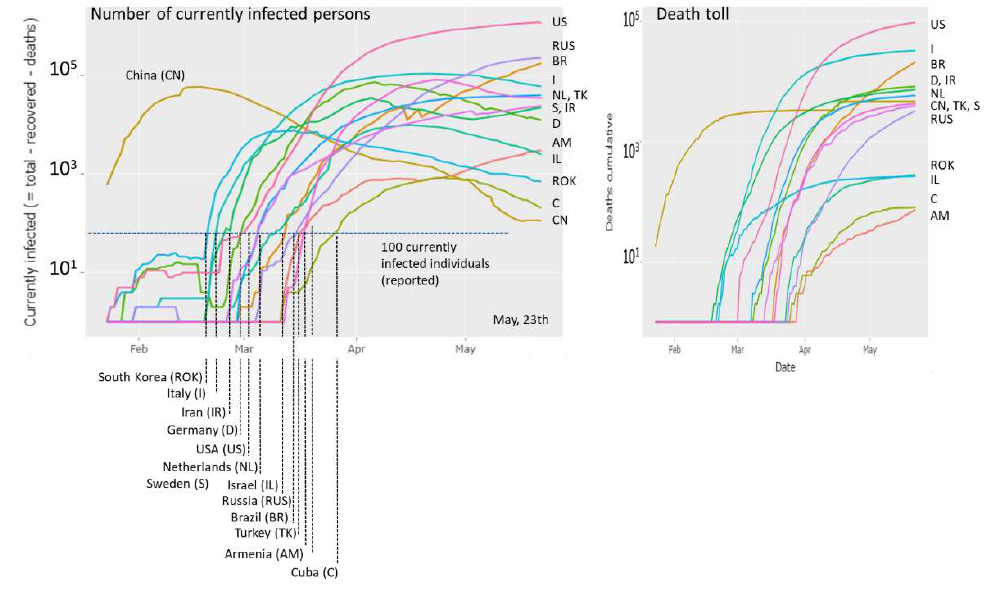
Figure 1. Covid-19 cases (left plot: currently infected, right plot: died individuals) in di ff erent countries as a function of date. The ‘100-cases per country’ threshold is crossed between end of February and end of March for the countries shown (except China). The time courses reflect growing (e.g., US, RUS, NL), slightly decaying (e.g., I, D, TK), strongly decaying (e.g., CH, ROK) regimes of epidemic or indications of bi-or multiphasic growth (e.g., AM, IR). The courses of the dead toll as a function of time reflect country-specific percentages of Covid-19 victims. The plots were generated in the Corona-viewer on a daily actualization-basis as described in the text.